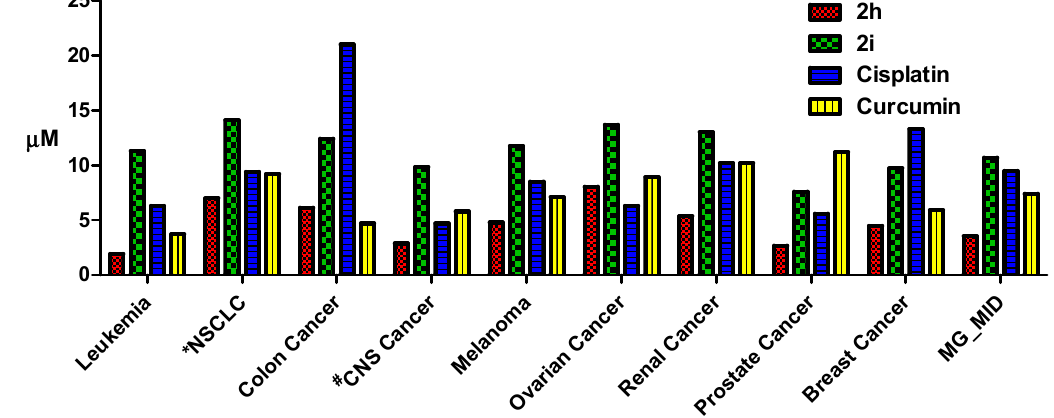
Figure 6. Mean growth inhibitory concentration (MG_MID GI 50 , µ M) of compounds 2h and 2i in comparison with cisplatin and curcumin. *NSCLC—Non-small Cell Lung Cancer, # CNS—Central nervous system.